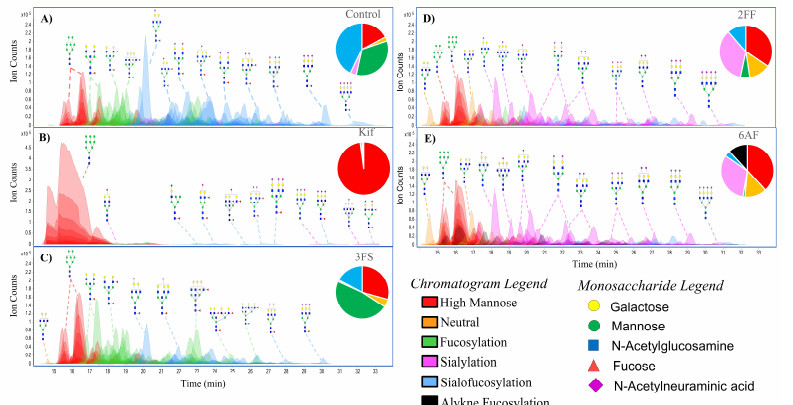
Figure 2. Extracted compound chromatograms of Caco-2, showing ( A ) control, ( B ) Kifunensine (Kif), ( C ) 2,4,7,8,9-Penta-O-acetyl- N -acetyl-3-fluoro-b- D -neuraminic acid methyl ester (3FS), ( D ) 2- deoxy-2-fluorofucose (2FF), and ( E ) 6-alkynyl fucose. Peaks are colored by glycan subtypes and annotated with the schematic representation of the glycan structures. Monosaccharide notations follow the Symbol Nomenclature for Glycans (SNFG) system [29] and N-glycans were drawn with GlycoWorkbench version 2.1[30].